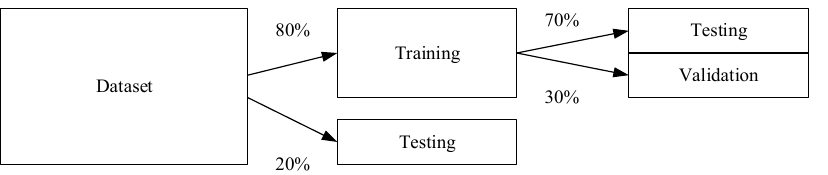
Figure 5. Dataset classification.